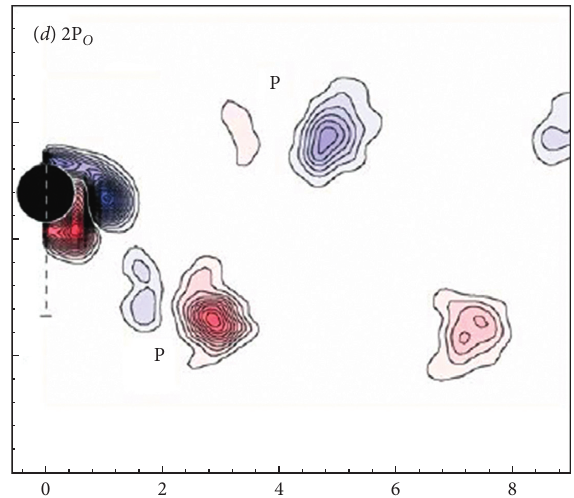
Figure 8: 2 P O mode vortex field by using DPIV, Morse and Williamson [27].